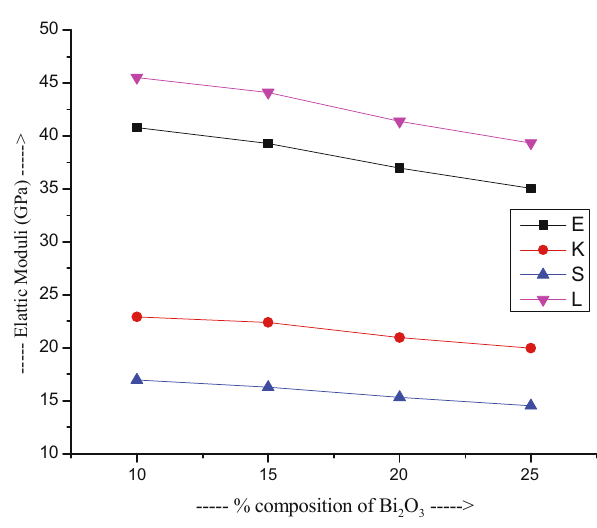
Figure 2: Elastic moduli for the samples.